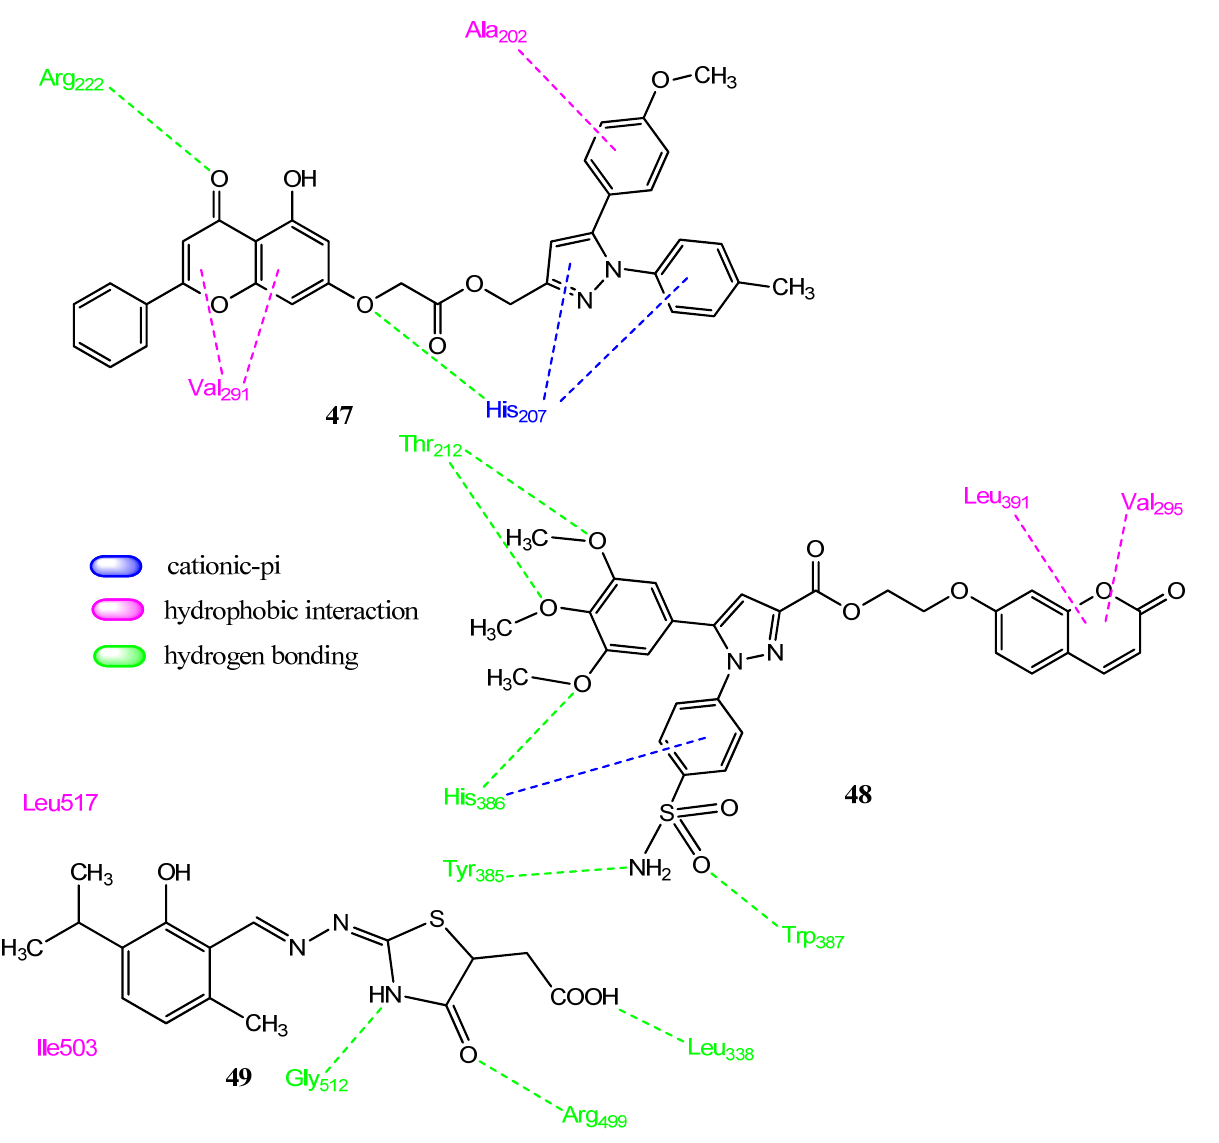
Figure 10. Structures of natural product–based hybrid molecules and their interactions with COX-2.